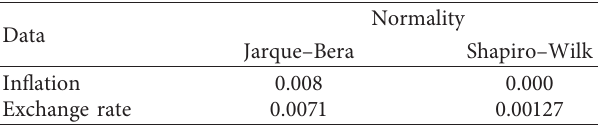
Table 5: Testing for normality of our GARCH(1,1) standardised residuals.